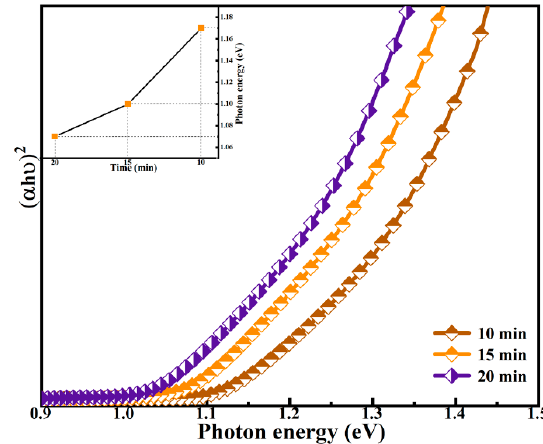
Figure 8. The curve of ( α h υ ) 2 vs h υ for CNZTSSe films selenized at 10 min, 15 min, and 20 min; The insert shows the variation curve of Eg with selenidation time.